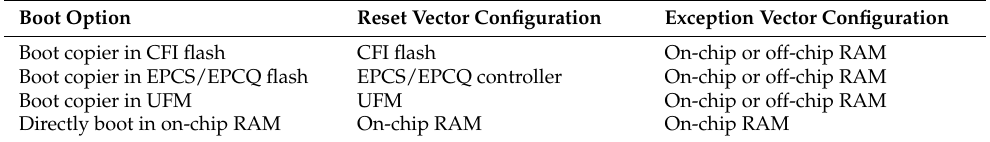
Table 4. Generic boot method of NIOS II program.